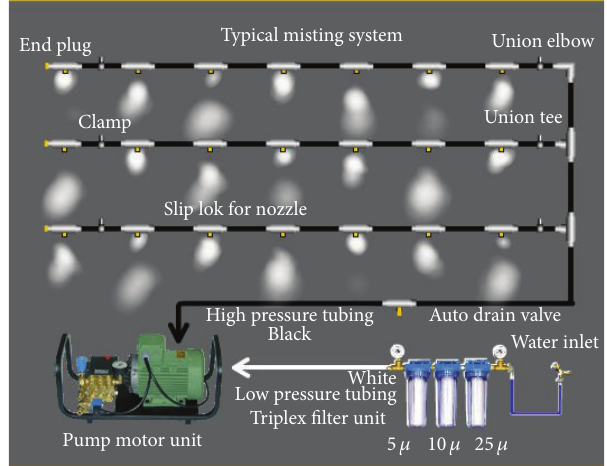
Figure 1: Typical representation of misting